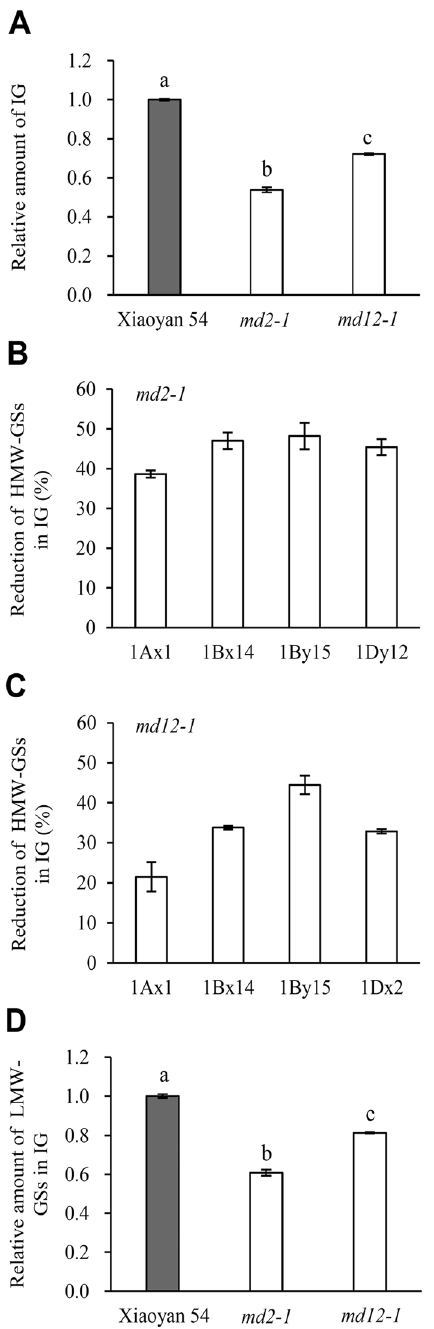
Figure 5. Comparative analysis of Xiaoyan 54 and two derivative knockout mutants ( md2-1 and md12-1 ) lacking the high-molecular-weight glutenin subunits (HMW-GSs) 1Dx2 and 1Dy12, respectively. The three lines were cultivated in Beijing in 2014/2015, and the resultant grain samples were collected for this set of analysis. ( A ) The amount of insoluble glutenin (IG) was decreased in md2-1 and md12-1 relative to that of Xiaoyan 54 (set as 1), with the decrease exhibited by md2-1 being substantially stronger. The values shown are means ± SE of three separate tests, and those labeled by different letters are statistically significant ( P < 0.05). ( B ) Reduction of the remaining four HMW-GSs (1Ax1, 1Bx14, 1By15 and 1Dy12) in the IG of md2-1 . The percentages of reduction were calculated by setting the amounts of the four subunits in the IG of Xiaoyan 54 as 100%. The values shown are means ± SE of three different tests. ( C ) Reduction of the remaining four HMW-GSs (1Ax1, 1Bx14, 1By15 and 1Dx2) in the IG of md12-1 . The percentages of reductions presented were calculated as described in ( C ). ( D ) The amount of low-molecular-weight glutenin subunits (LMW-GSs) was reduced in md2-1 and md12-1 relative to that of Xiaoyan 54 (set as 1), with the reduction shown by md2-1 being considerably stronger. The values shown are means ± SE of three different tests, and those labeled by different letters are statistically significant ( P < 0.05). The same set of analysis was also conducted using the grain samples of the three lines harvested in 2015/2016 with similar results obtained (Figure